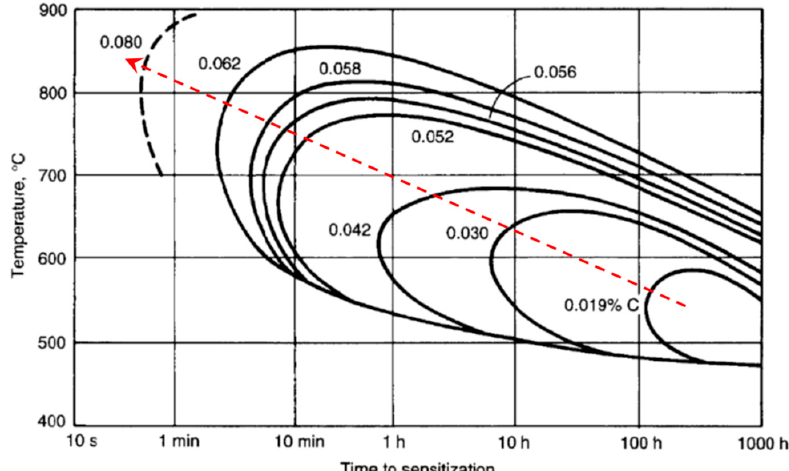
Figure 10. Precipitation kinetics of Cr 23 C 6 carbide as a function of carbon content [55]. The dotted red arrow indicates more rapid kinetics due to carbon di ff usion from the carbon steel to the clad.